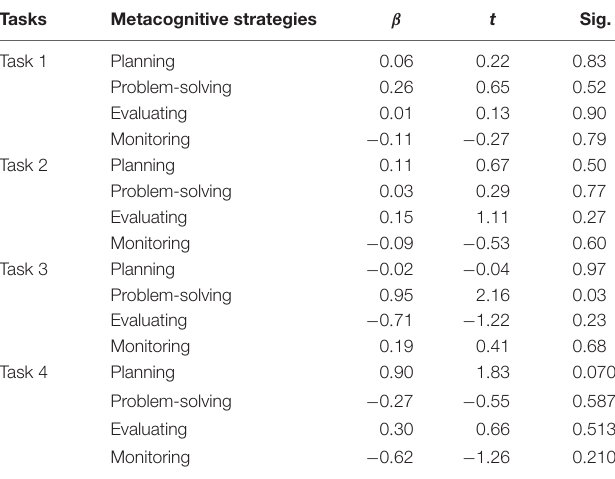
TABLE 5 | Relationships between individual metacognitive strategies and speaking performance across tasks. Tasks Metacognitive strategies β t